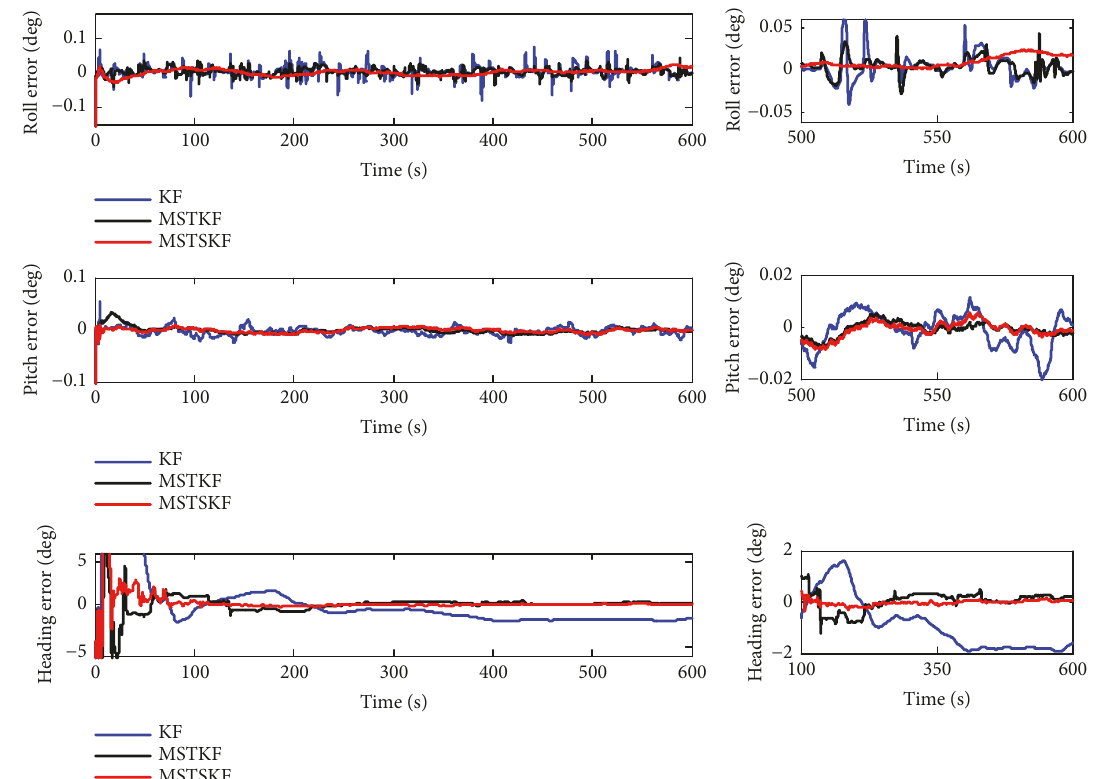
Figure 1: Attitude angle error of the simulation when the system noise covariance matrix is magnified 50